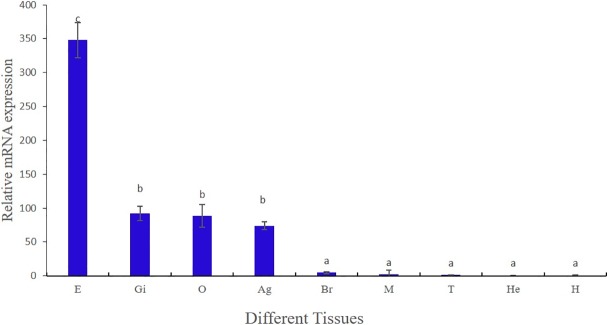
Mn-MIH expression in different tissues of M. Nipponense.Notes: Tissues were labeled as following: Notes: E: eyestalk; Gi: gill; O: ovary; Ag: abdominal ganglion Br: brain; M: muscle; T: testis; He: hepatopancreas; H: heart. It was normalized to the Mn-β-Actin transcript level. Data were shown as means ± SD (standard deviation) of three separate individuals in the tissues. Bars with different letters were significantly different (P < 0.05).